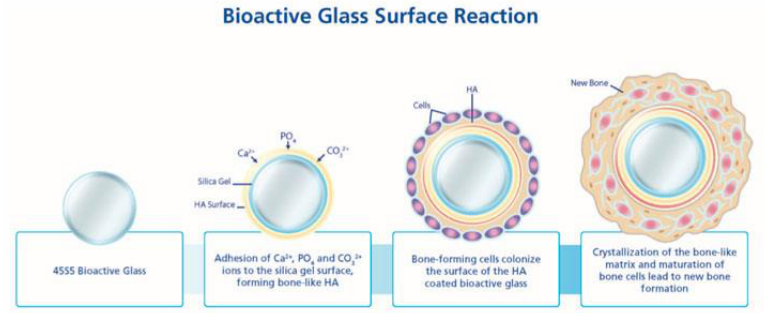
Figure 2. Bioactivity and bone enhancement steps of bioglass. Reproduced from [53].